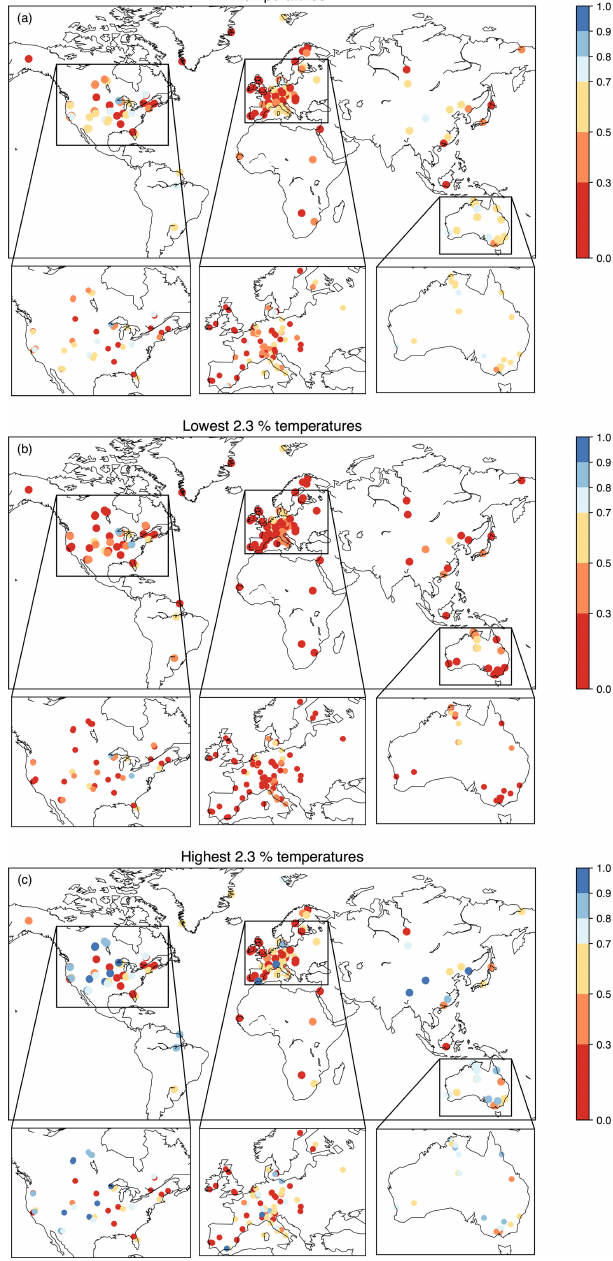
Figure 4. Maps of NEE measurement ratios. Panel (a) shows the NEE measurement ratios for the overall temperature distribution, (b) for the lower extreme and (c) for the upper extreme. Each dot on the map represents a flux tower site.